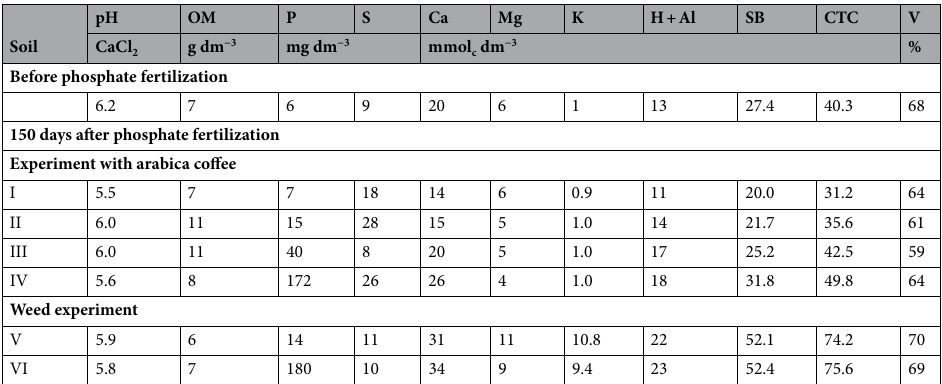
Table 1. Chemical analysis of the soil, before phosphate fertilization and after 150 days in contact with phosphate fertilizer, Jaboticabal—SP, 2019. pH in CaCl 2 by potentiometry; Organic matter (OM) by Spectrophotometry; P in resin by spectrophotometry; S for turbidimetry; Ca by Atomic Absorption Spectrometry; Mg by Atomic Absorption Spectrometry; K by Atomic Absorption Spectrometry; H + Al in SMP Buffer by potentiometry; Sum of bases (SB) = Ca + Mg + Na + K; cation exchange capacity (CTC) = SB + H + Al; base saturation index (V%) = (SB/CTC) × 100 (Reference: IAC